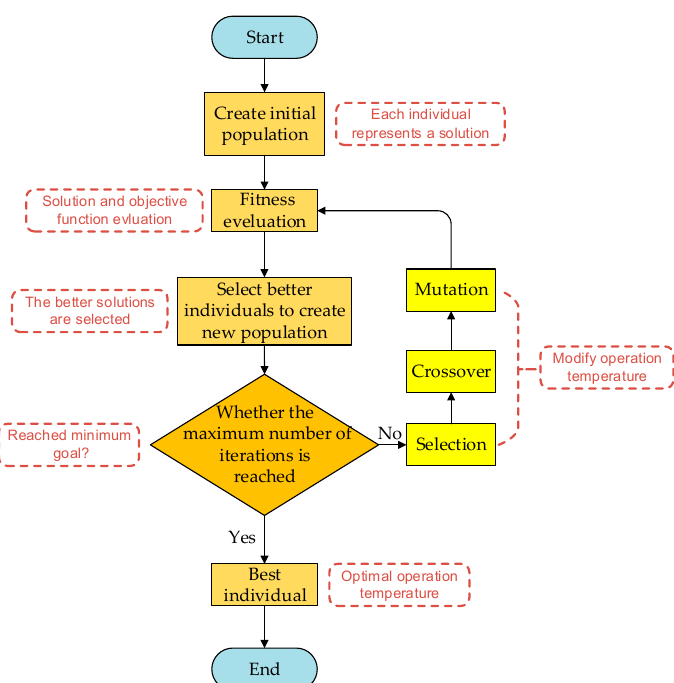
Figure 9. Flow chart of the genetic algorithm. Energies 2019 , 12 , x FOR PEER REVIEW